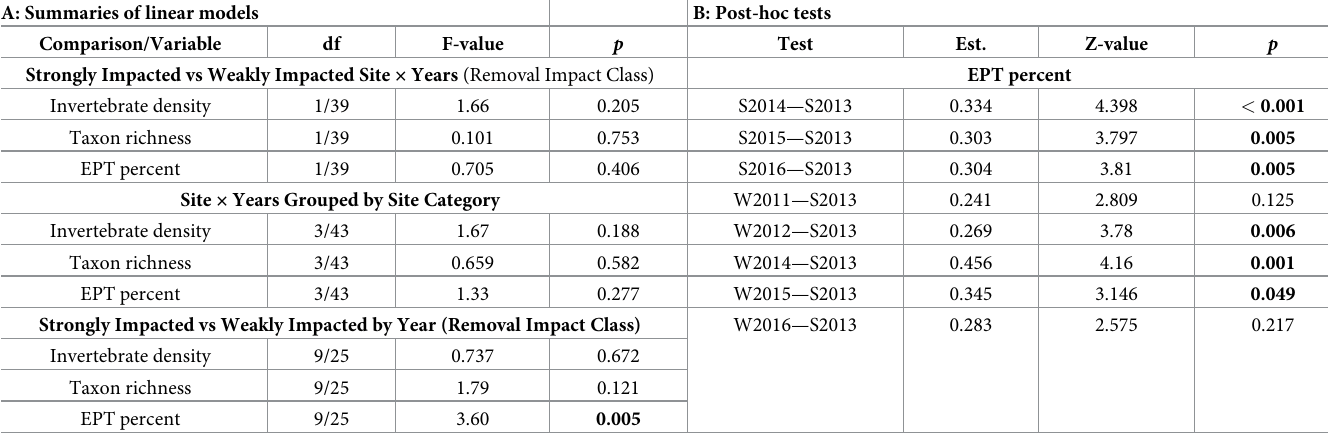
Table 2. A) ANOVA tables of linear models of summary variables Invertebrate density, Taxon richness, and EPT percent as predicted by different site categorizations. B) Post hoc tests (Tukey HSD) for differences in EPT percent between strongly impacted (S) and weakly impacted (W) sites by